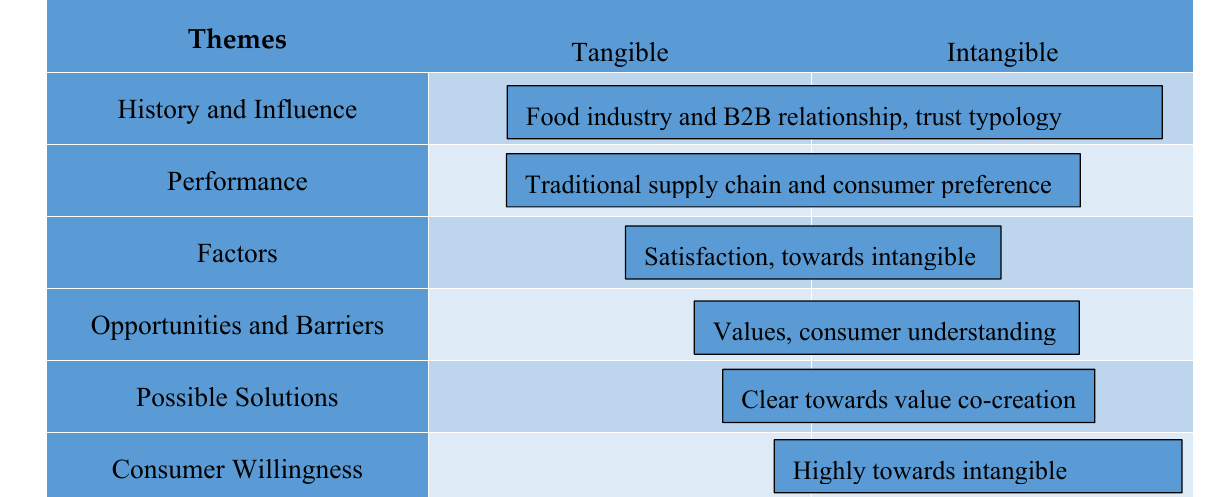
Figure 5. Exchange from tangible to intangible definitions of exchange.